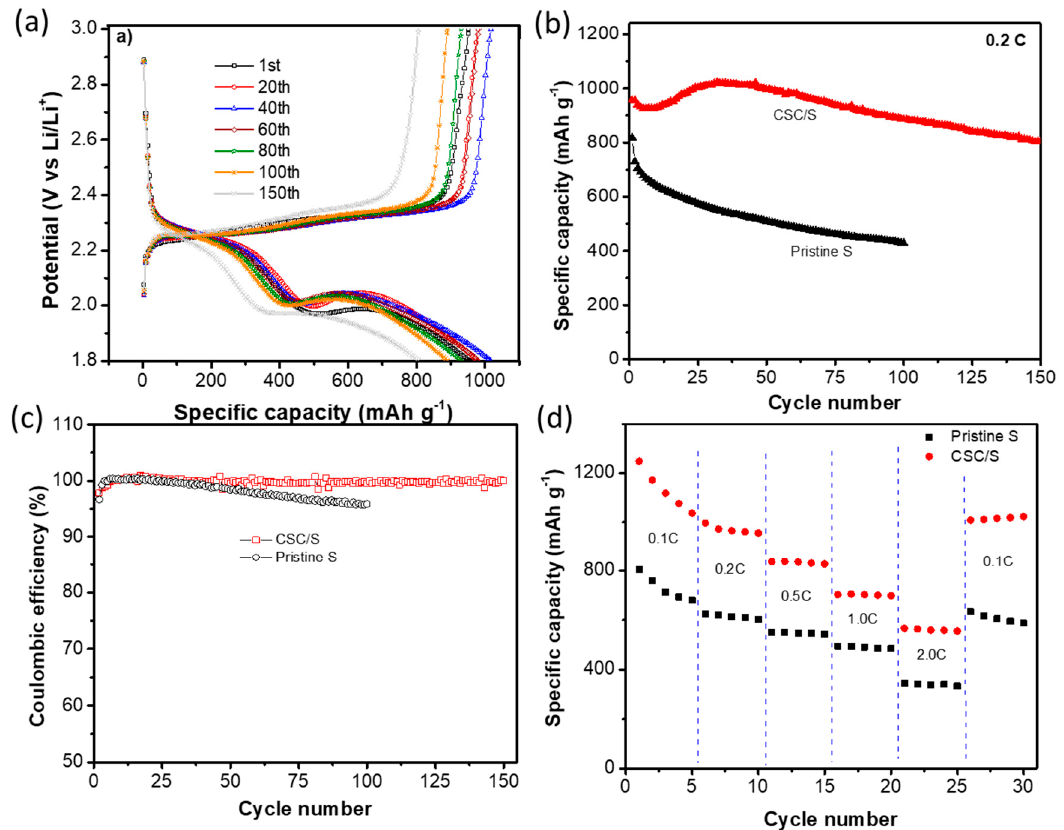
Figure 5. Electrochemical characterization of CSC/S as a cathode in the Li–S cells: ( a ) Charge/discharge voltage profiles at various cycles at a rate of 0.2C, the corresponding ( b ) cycling performance and ( c ) coulombic efficiency plots, and ( d ) the rate performance of the CSC/S electrode at various incremental C rates.